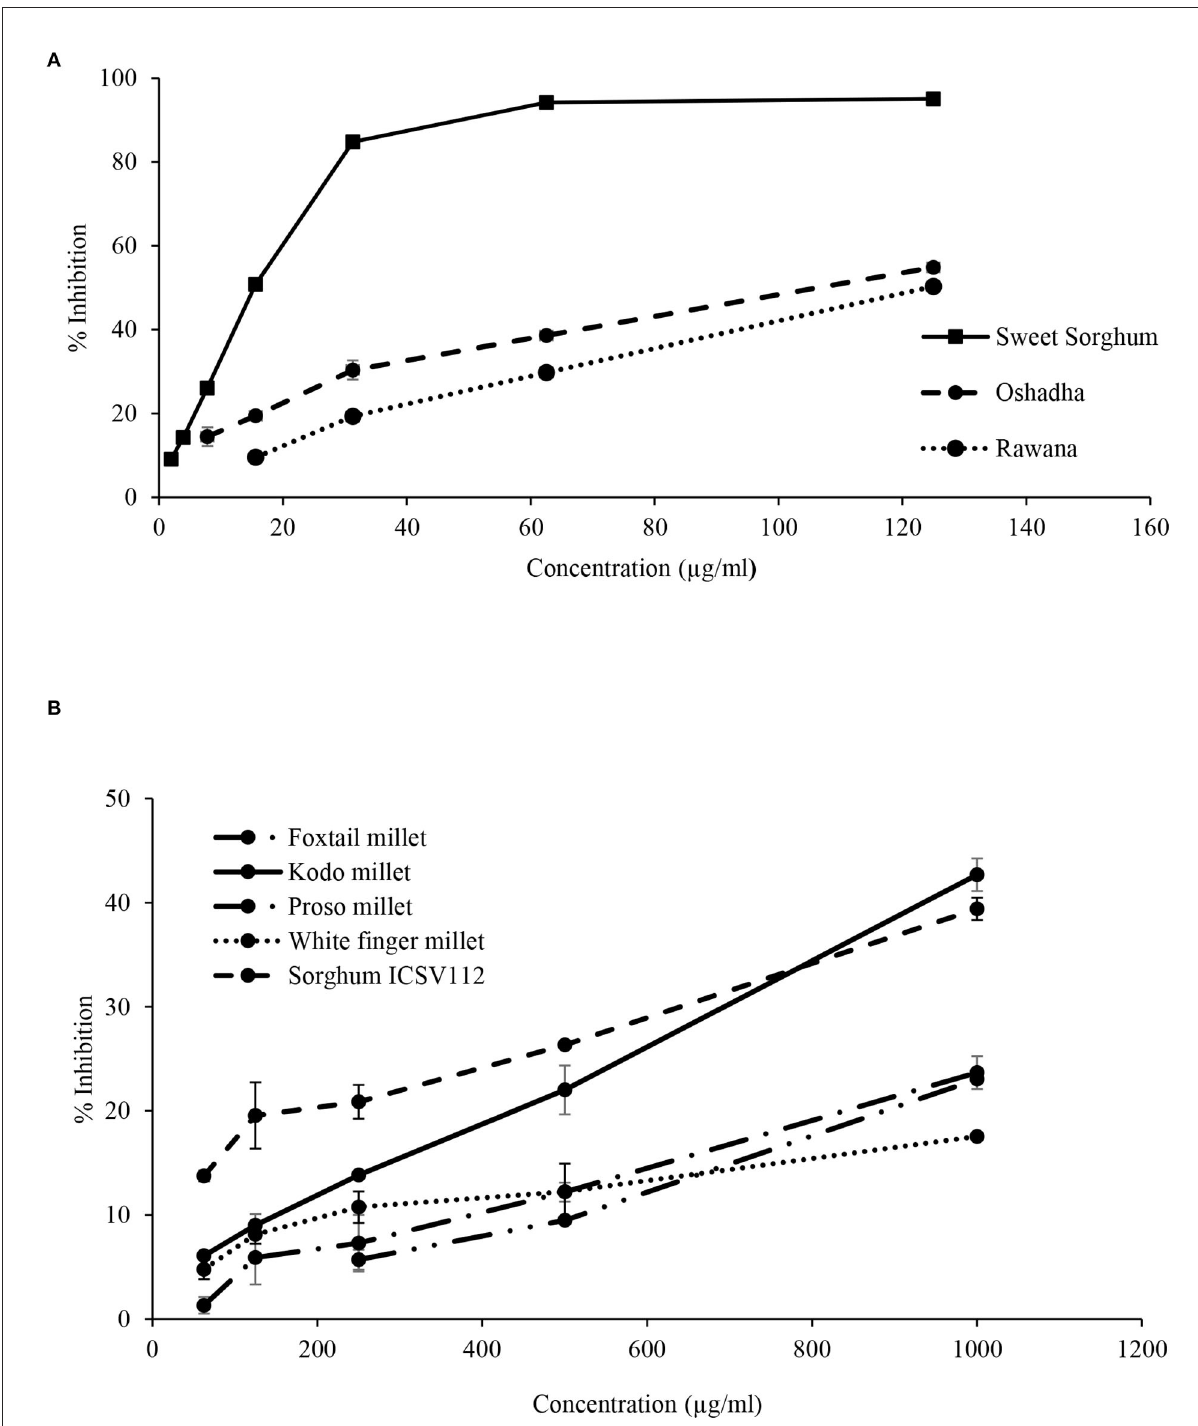
FIGURE12 Dose-response relationship of selected samples for DPPH radical scavenging activity. (A) Dose-response relationship of sweet sorghum, Oshadha, and Rawana: IC 50 values: 15.45 ± 0.21 e , 85.10 ± 3.13 e and 120.93 ± 2.15 e µ g/ml respectively. (B) Dose-response relationship of white finger millet, foxtail millet, proso millet, sorghum ISCV112, and Kodo millet: IC 50 : 3455.2 ± 55.4 a , 2170.7 ± 97.7 b , 2168.0 ± 55.9 b , 1383.4 ± 48.1 c and 1075.6 ± 56.3 d µ g/ml, respectively. IC 50 values superscripted by different letters are significantly different at p <